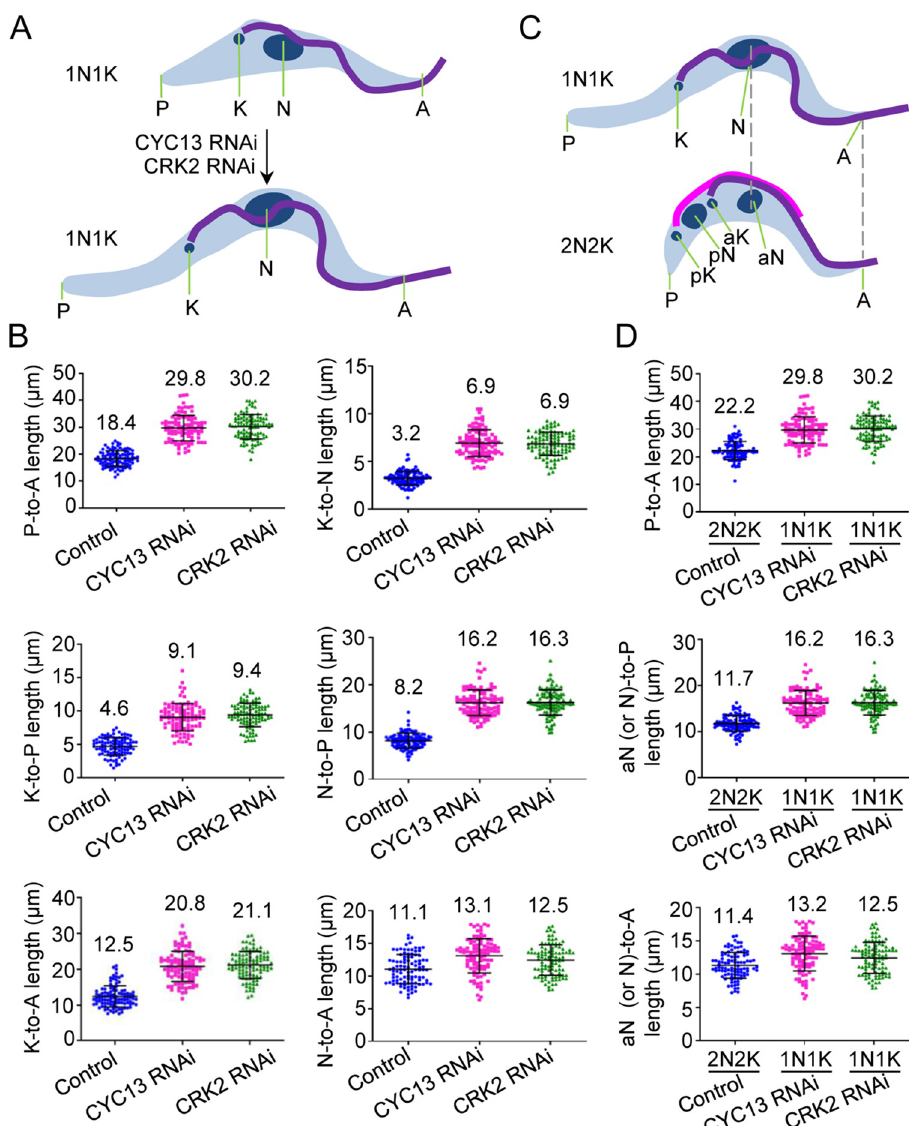
Fig 2. Analysis of the effects of CYC13 RNAi and CRK2 RNAi on cell morphology. ( A ). Schematic drawing of 1N1K cells from non-induced control and RNAi of CYC13 or CRK2, showing the effect of RNAi on cell morphology, for the measurement presented in panel B . P, posterior; A, anterior; K, kinetoplast; N, nucleus. ( B ). Measurement of the distance between kinetoplast, nucleus, cell posterior, and cell anterior of the 1N1K cells from non-induced control, CYC13 RNAi (48 h), and CRK2 RNAi (48 h). 100 cells from each cell line were used for measurement. The number on each plot indicates the average length. ( C ). Schematic drawing of a 1N1K cell from CRK2 RNAi or CYC13 RNAi and a 2N2K cell from the non-induced control for the measurement presented in panel D . P, posterior; A, anterior; K, kinetoplast; N, nucleus; pK, posterior kinetoplast; pN, posterior nucleus; aK, anterior kinetoplast; aN, anterior nucleus. ( D ). Measurement of the distance between cell posterior, cell anterior, and nucleus (1N1K cells) or anterior nucleus (2N2K cells) of the 2N2K cells from the non-induced control and the 1N1K cells after CYC13 RNAi (48 h) and CRK2 RNAi (48 h). 100 cells for each cell line were used for measurement. The number on each plot indicates the average length. posterior elongation, leading to the increase of the cell body length and the migration of the kinetoplast, but not the nucleus, toward the posterior portion of the cell.